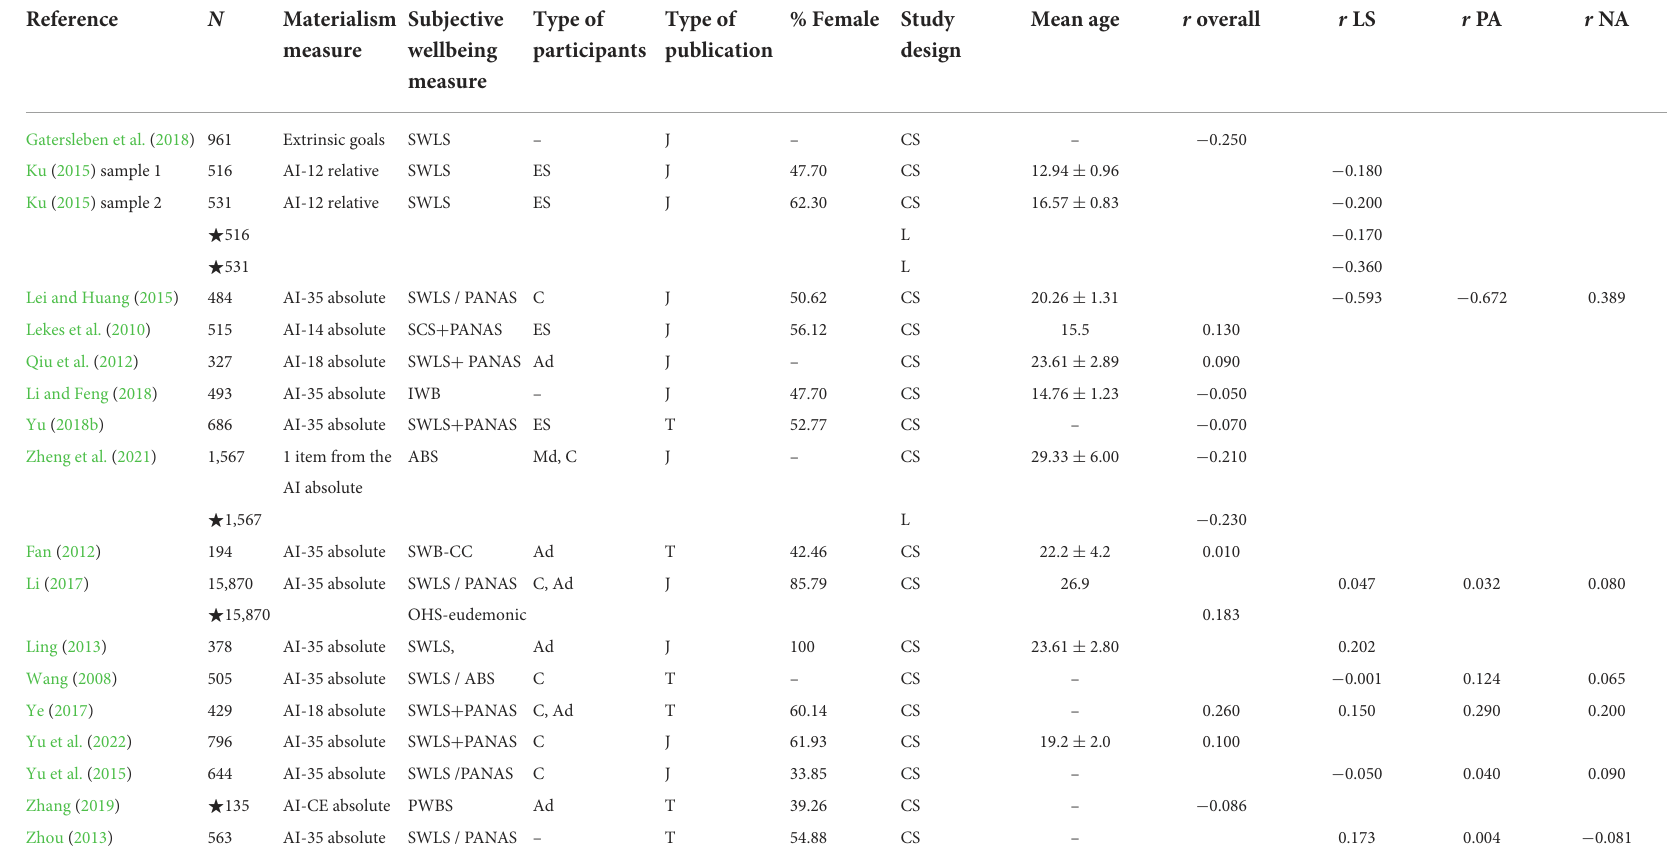
(1) Samples with a star ( ⋆ ) record effect sizes using longitudinal data or measures based on eudemonic approach, which were not included in the calculation of overall mean effect size to keep the independency of the effect sizes, and they were only included in subgroup analyses; (2) MVS, Materialistic Value Scales (Richins and Dawson, 1992; Li and Guo, 2009); MVS-C, Materialistic Value Scale for Children (Opree et al., 2011), AI = aspiration index (Kasser and Ryan, 1996; Tang et al., 2008), AI-CE, Aspiration Index for Chinese employee (Zhang, 2019); Extrinsic goals, extrinsic goal items (Kasser, 2005); a plus sign ( + ), the combination of the two measures of subjective wellbeing, a slash (/), using two measures of subjective wellbeing separately;SWLS,SatisfactionWithLifeScale(Dieneretal.,1985)andPANAS,PositiveAffectScaleandNegativeAffectScale(Watsonetal.,1988; Emmons,1992; Qiuetal.,2008),ABS,AffectBalanceScale(Bradburn,1969,2015),